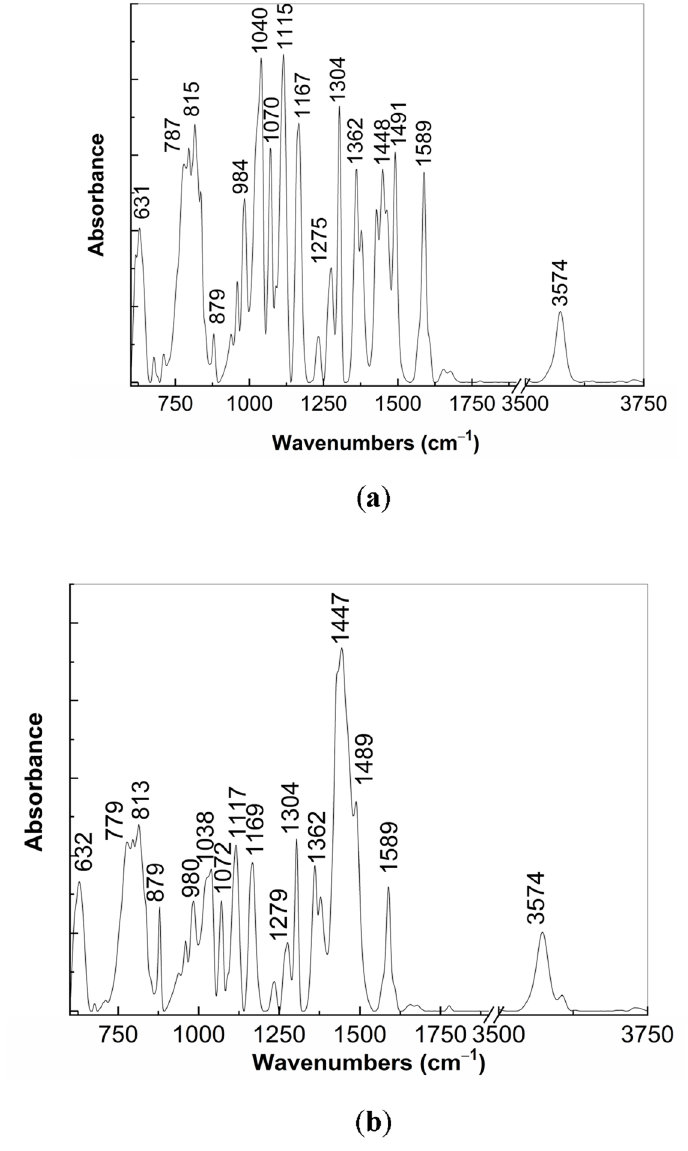
Figure 13. FTIR spectra of NaOH-reacted PS ( 1 ), when the weight ratio between PS ( 1 ) and NaOH is of 1:1 ( a ) and 1:3 ( b